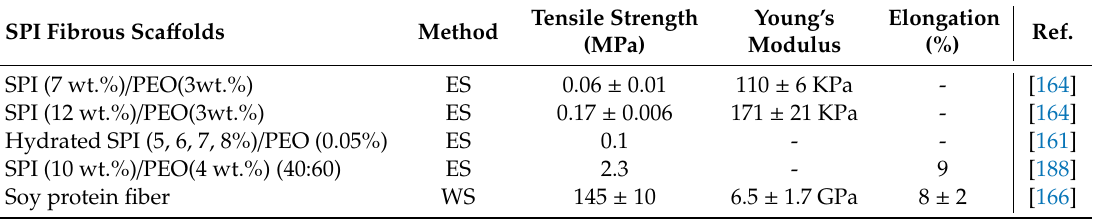
Table 5. Mechanical properties of soy protein isolate (SPI) fibrous sca ff olds for skin tissue regeneration. SPI Fibrous Sca ff